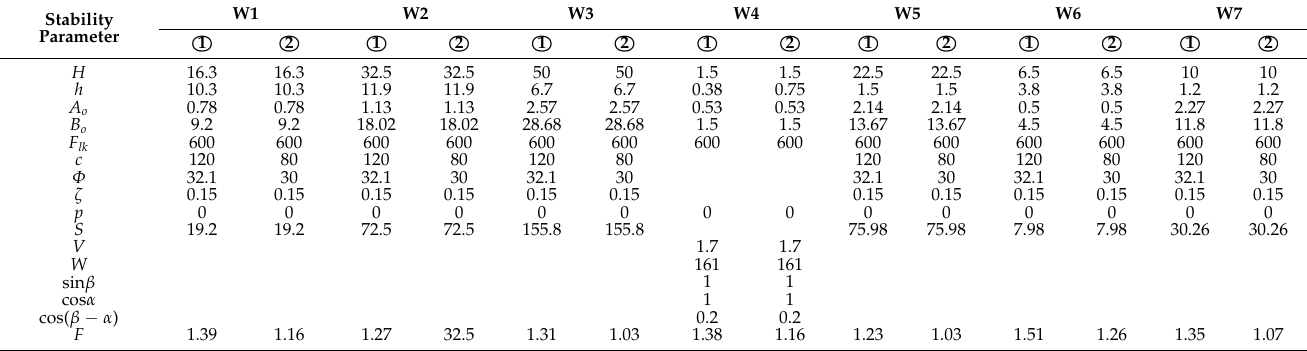
Table 4. Stable value parameters.